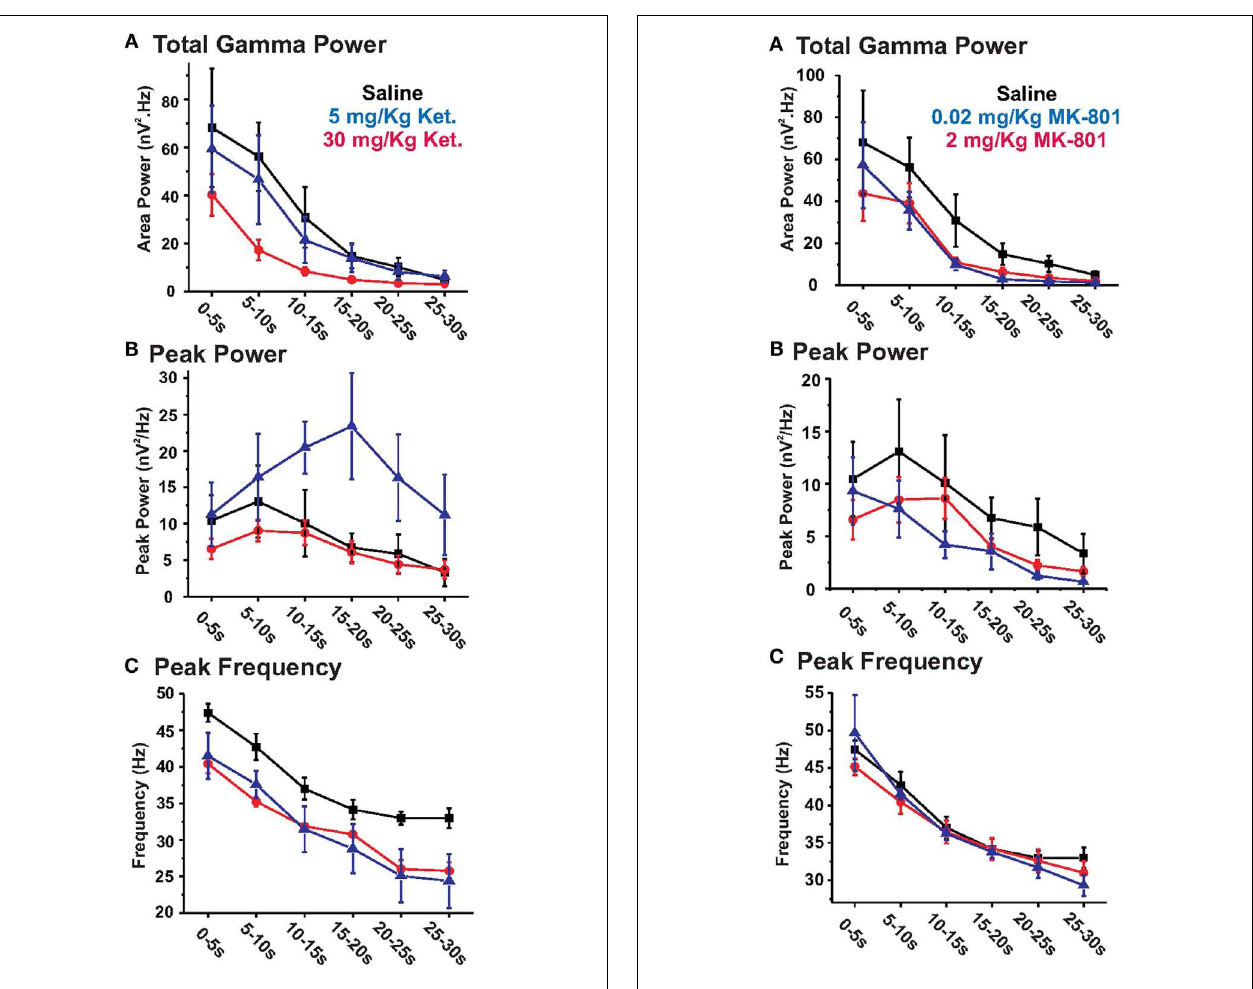
peak frequency of elicited oscillations ( F 1,13 = 52.77; p < 0.01),